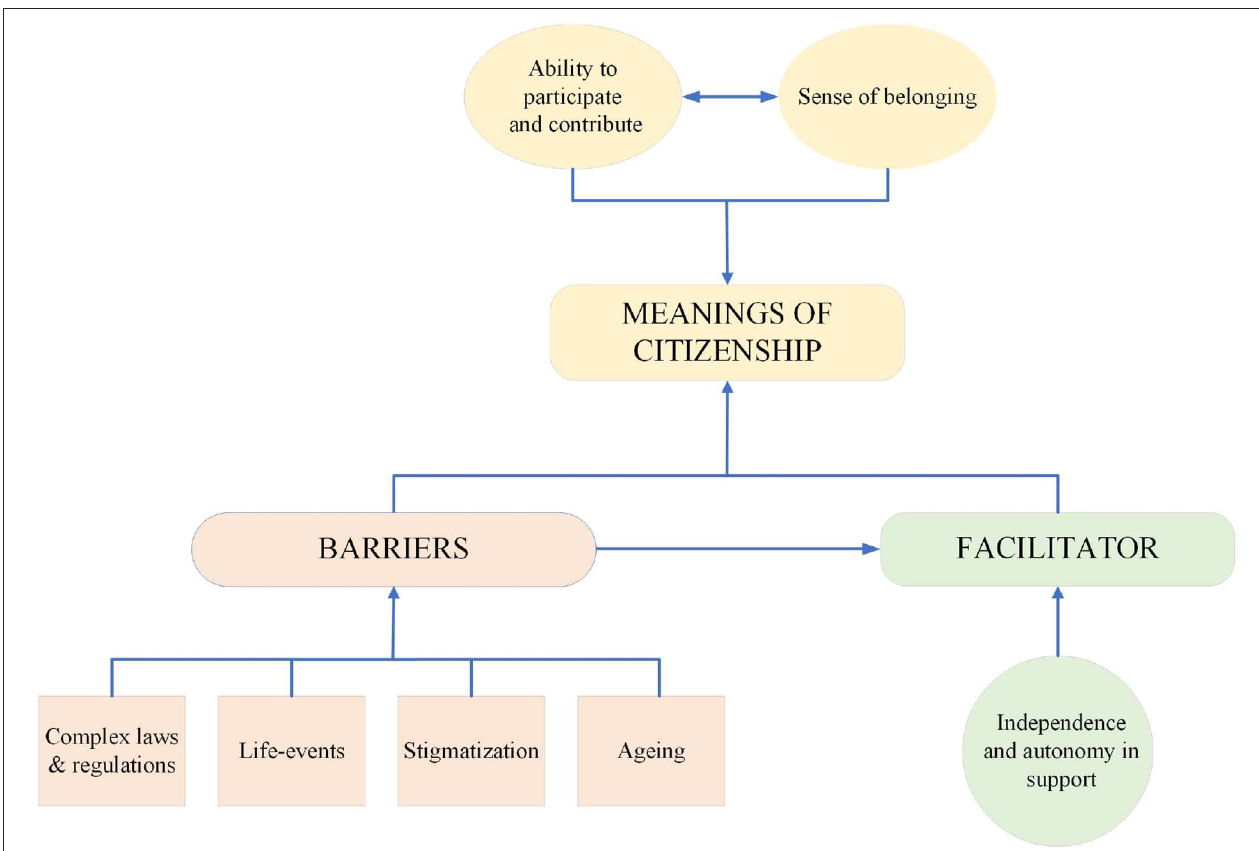
FIGURE 1 | Facilitator and barriers: interrelations and relation with citizenship in adults with CP. This figure shows that “meanings of citizenship” is influenced by the “facilitator” and “barriers.” “Barriers” also affect “independence and autonomy is